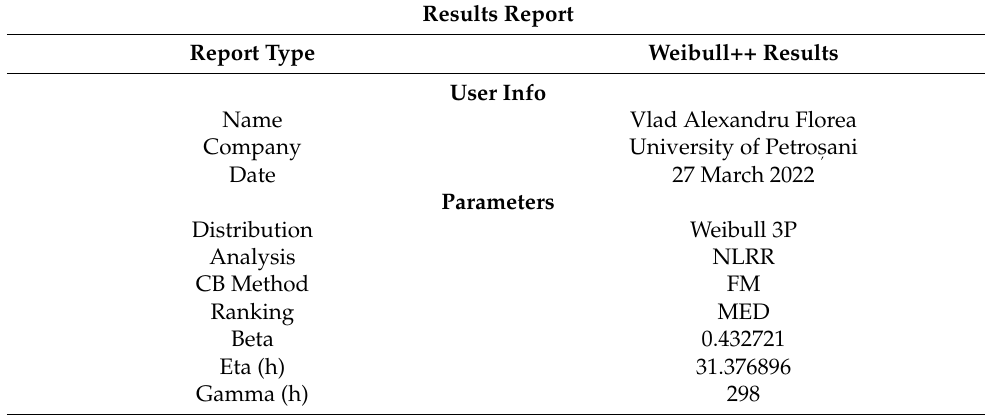
Table 7. Adopted normalized tri-parametric Weibull repartition law parameters for the captive